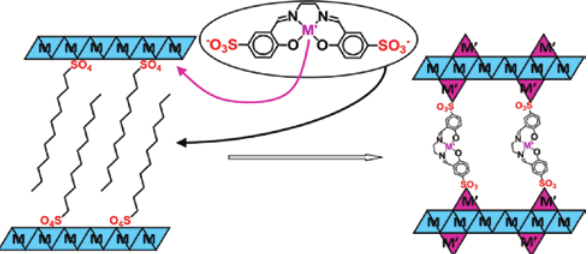
Figure 21: The insertion grafting of Salen-type complexes within lamellar copper or cobalt hydroxides leads to a drastic change in the structure and composition of the inorganic layers due to pos- sible dual exchange mechanism, i.e. anionic and cationic. Reprinted with permission from [145]. Copyright 2012 Wiley.